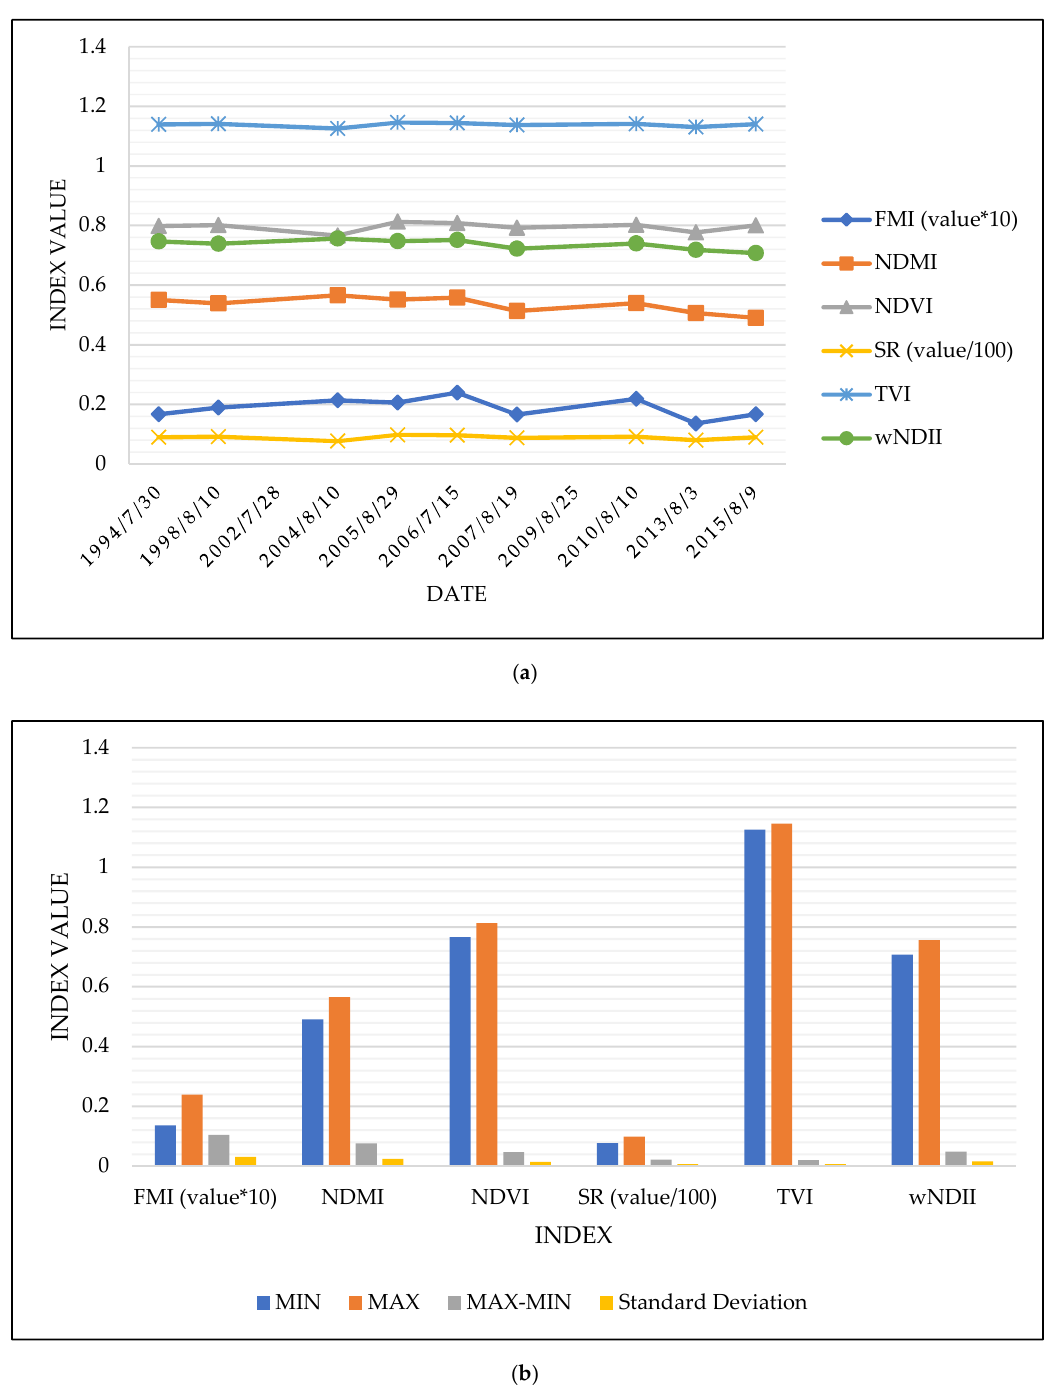
Figure 14. Time series of locality with minimal disturbance ( a ); and the statistical information ( b ) (Locality 10) (Source: Own work).